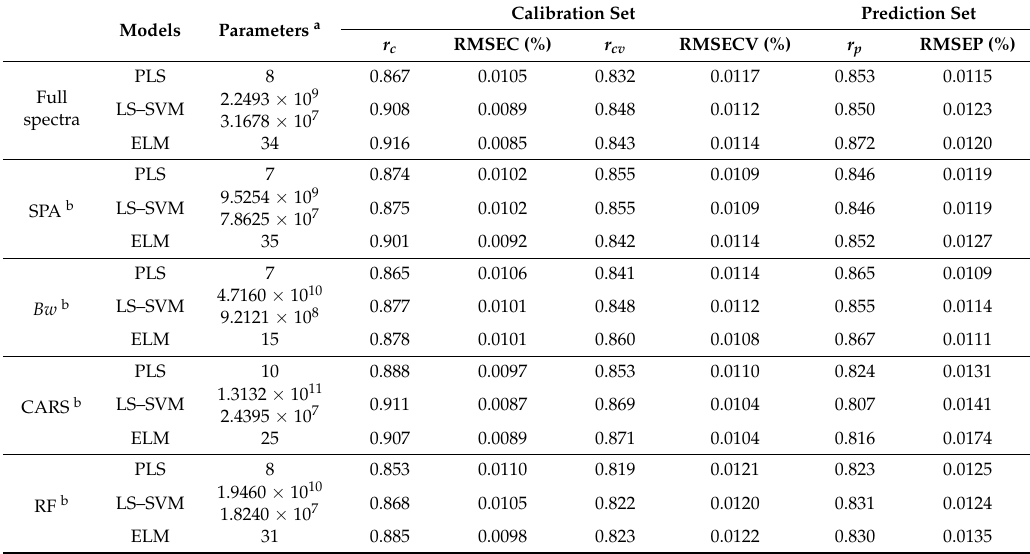
Table 4. Results of regression models for peiminine content